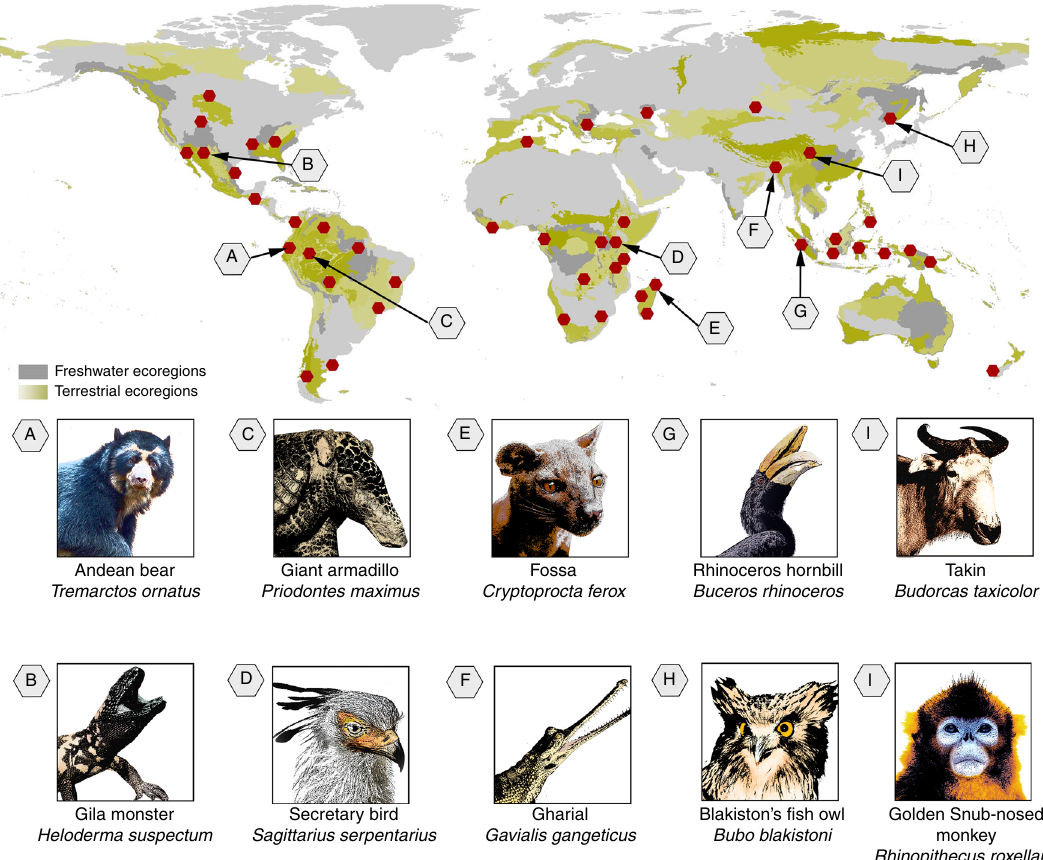
Fig. 2 Visualization of prioritized places and candidate fl agship species. The map shows the 47 places and a sample of the candidate fl agship species (panels A – I) delivered from the integrated approach for Scenario h (Fig. 1h, Table 2). See Supplementary Data Table 2 for full list of species. See Supplementary Table 3 for associated places and